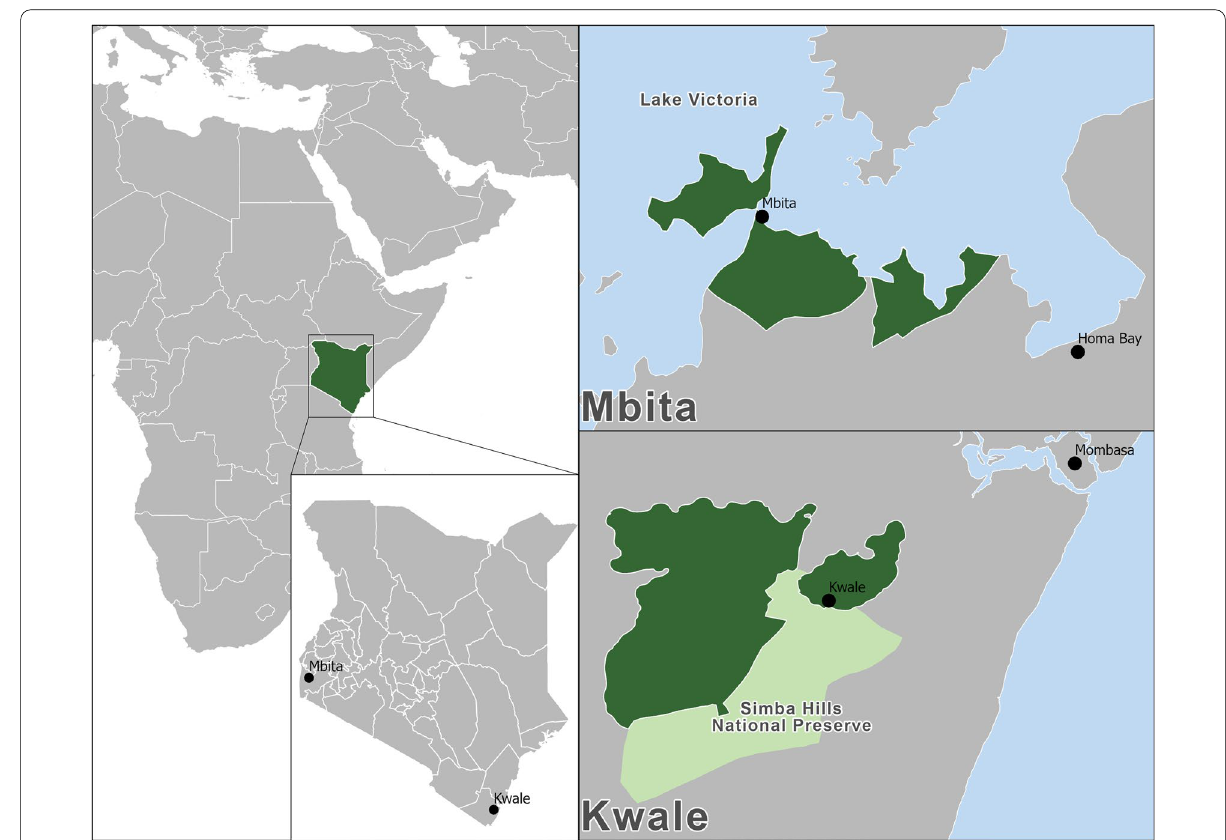
Fig. 2 Map of Kenya and study